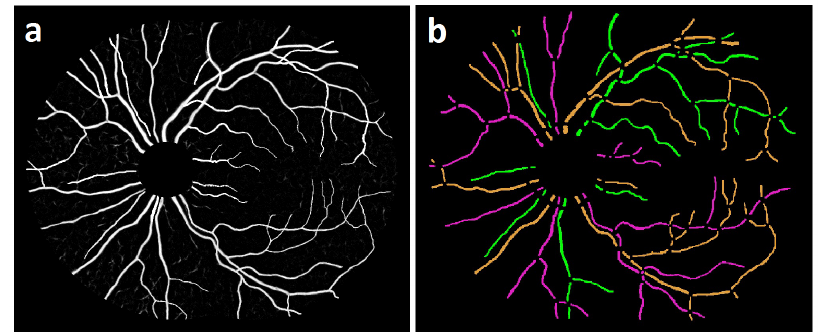
Figure 7. Image example: a) Vessel probability image b) Structural mapping of vessel network.